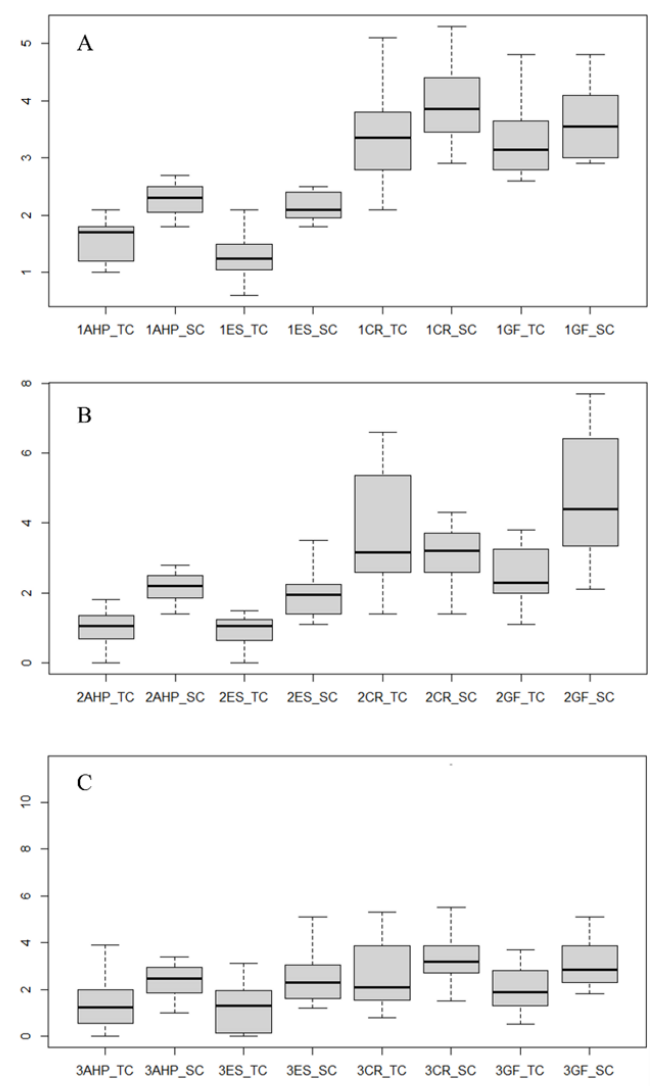
Figure 2. Visual representation of mean values and respective standard deviations of marginal gap measurements (µm) divided according to the endodontic sealer (AH Plus Bioceramic Sealer (AHP), EndoSequence BC Sealer HiFlow (ES), C-Root SP (CR), and GuttaFlow Bioseal (GF)) and the selected obturation technique (single-cone technique (SC) and thermomechanical condensation (TC)). Image ( A ) shows represented data regarding the marginal gap measured in the root canal apical third; image ( B ) shows represented data regarding the marginal gap measured in the root canal middle third, whilst image ( C ) shows represented data regarding the marginal gap measured in the root canal coronal third.